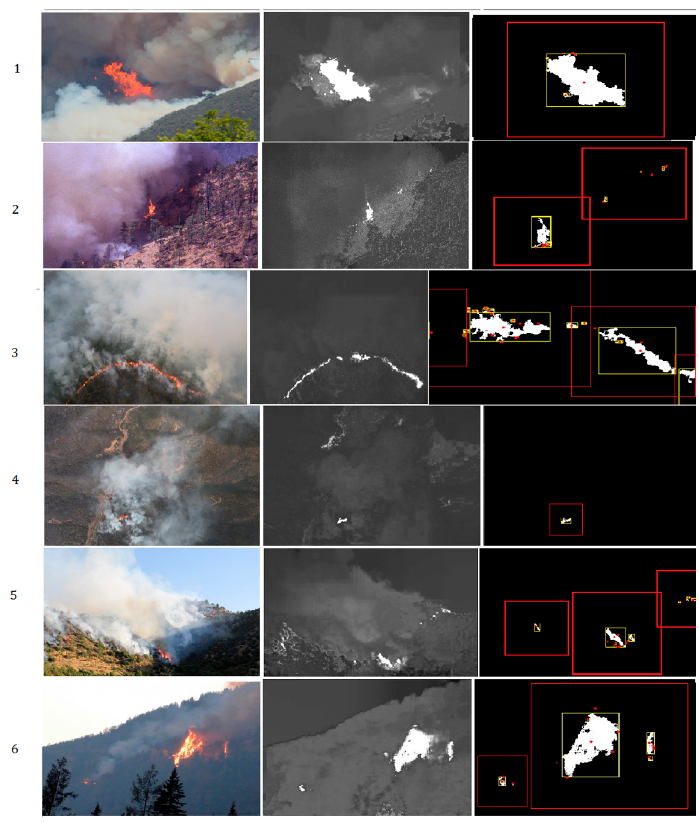
Figure 6. The saliency detection-based image segmentation: ( 1 ) Original image; ( 2 ) Saliency detection results; ( 3 ) ROI selection with logistic regression classifier and segmentation; ( 4 ) Segmented standard sized image for Fire_Net training. ( a ) Image with both flame and smoke features; ( b ) Image with only smoke feature; ( c ) Image with multiple fire regions.